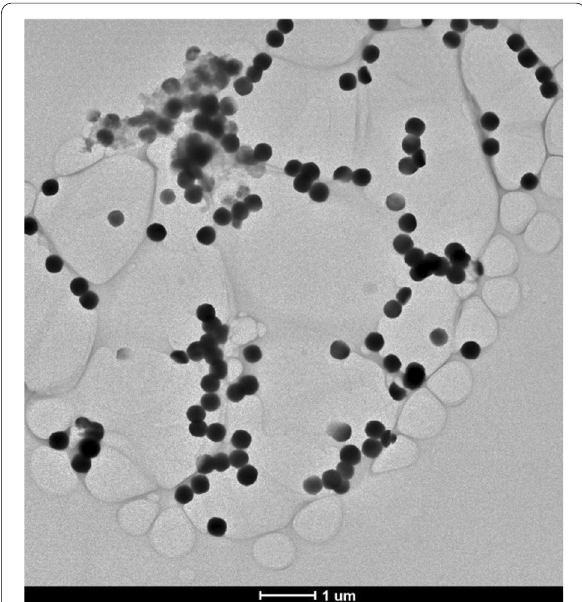
Fig. 7 TEM image of BSA-loaded nanoparticle